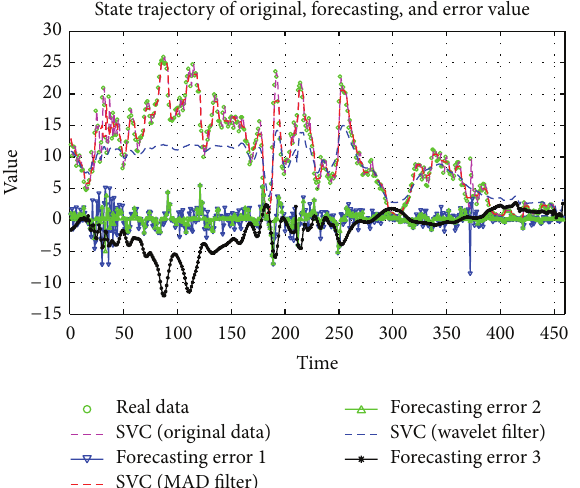
Figure 10: Final forecasting results via